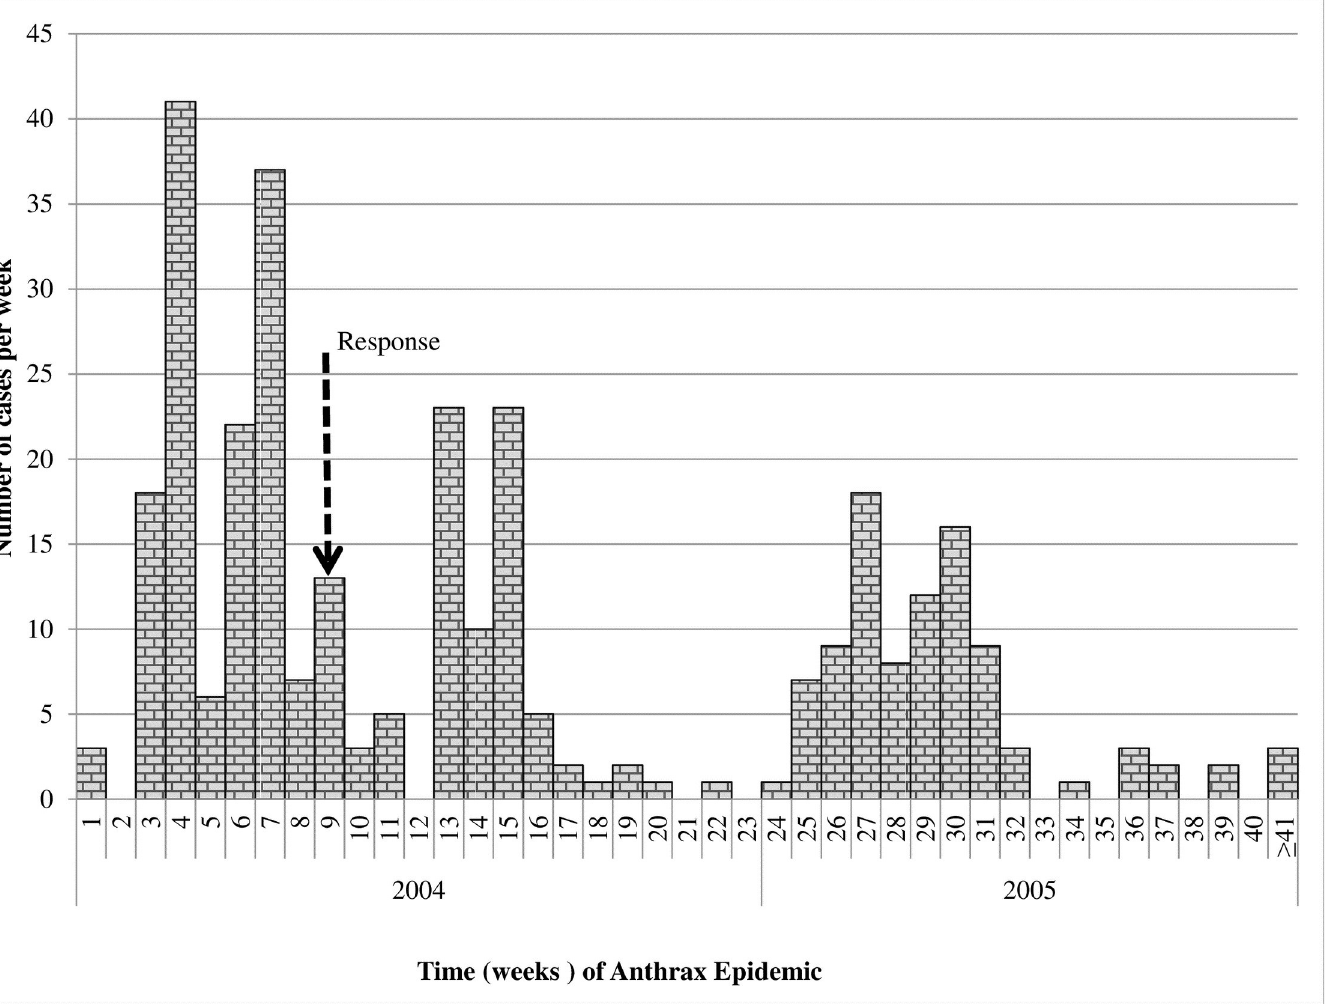
Fig 5. Epidemic curve showing patterns of epidemic spread for weekly anthrax cases in Hippopotamus . This outbreak occurred in clustered waves (epidemic generations), lasted 42 weeks from 25 July 2004 to May 2005 and died after 3 generations. Clusters that spanned over 20 days were considered protracted single outbreaks beyond anthrax incubation period or multiple outbreaks (Tables 2 and 3). Dashed line shows time in week 9 of outbreak when management intervention for carcass disposal was initiated. Number of cases did not drastically decline but epidemic peaks in the second and third epidemic generations dropped below the peak in the first wave instead of becoming successively